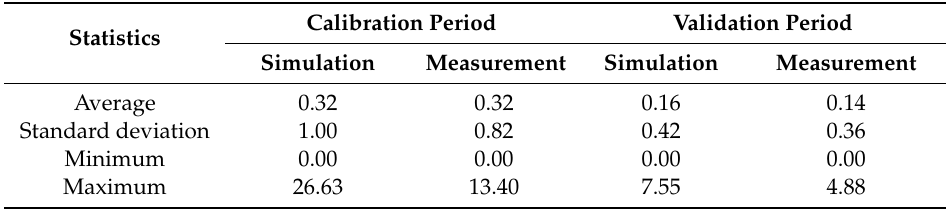
Table 6. Comparison of mean, standard deviation, minimum and maximum daily mean streamflow (m 3 / s) between measured and simulated values for the baseline model in the calibration (1998–2005) and validation (2006–2008) periods at the Kožbanjšˇcek catchment main